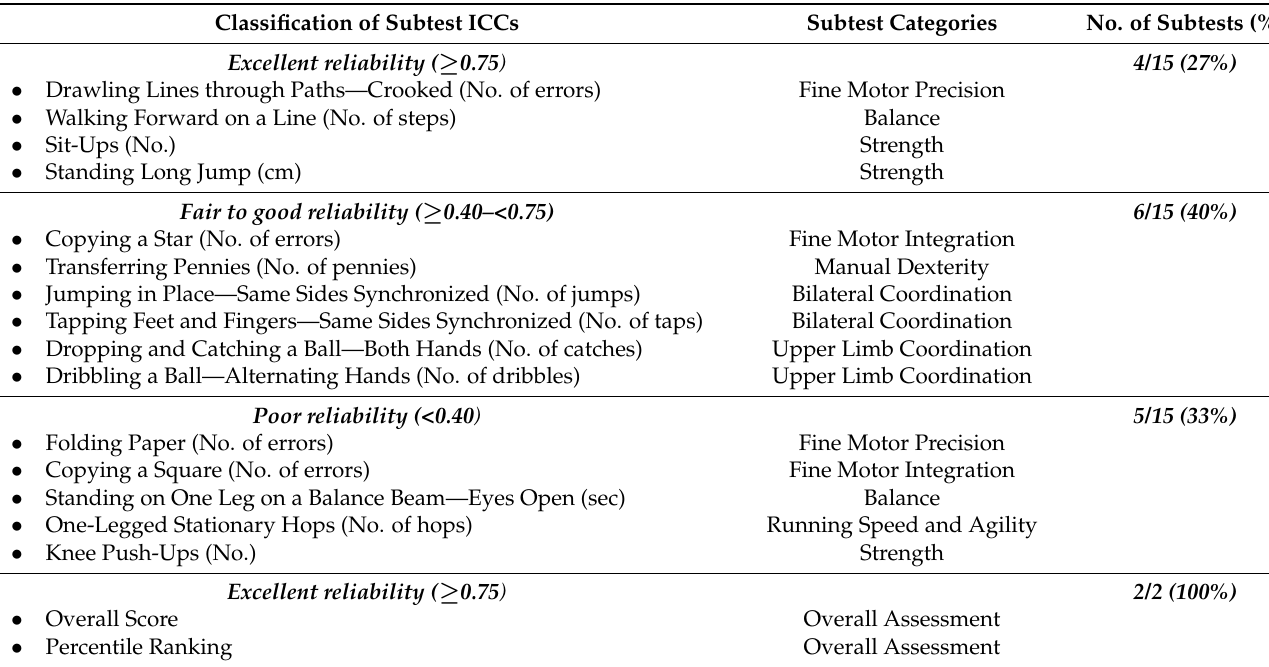
Table 4. Classification of the test–retest reliability (1CC; 95% CI) for the BOT-2 SF subtest and overall assessment